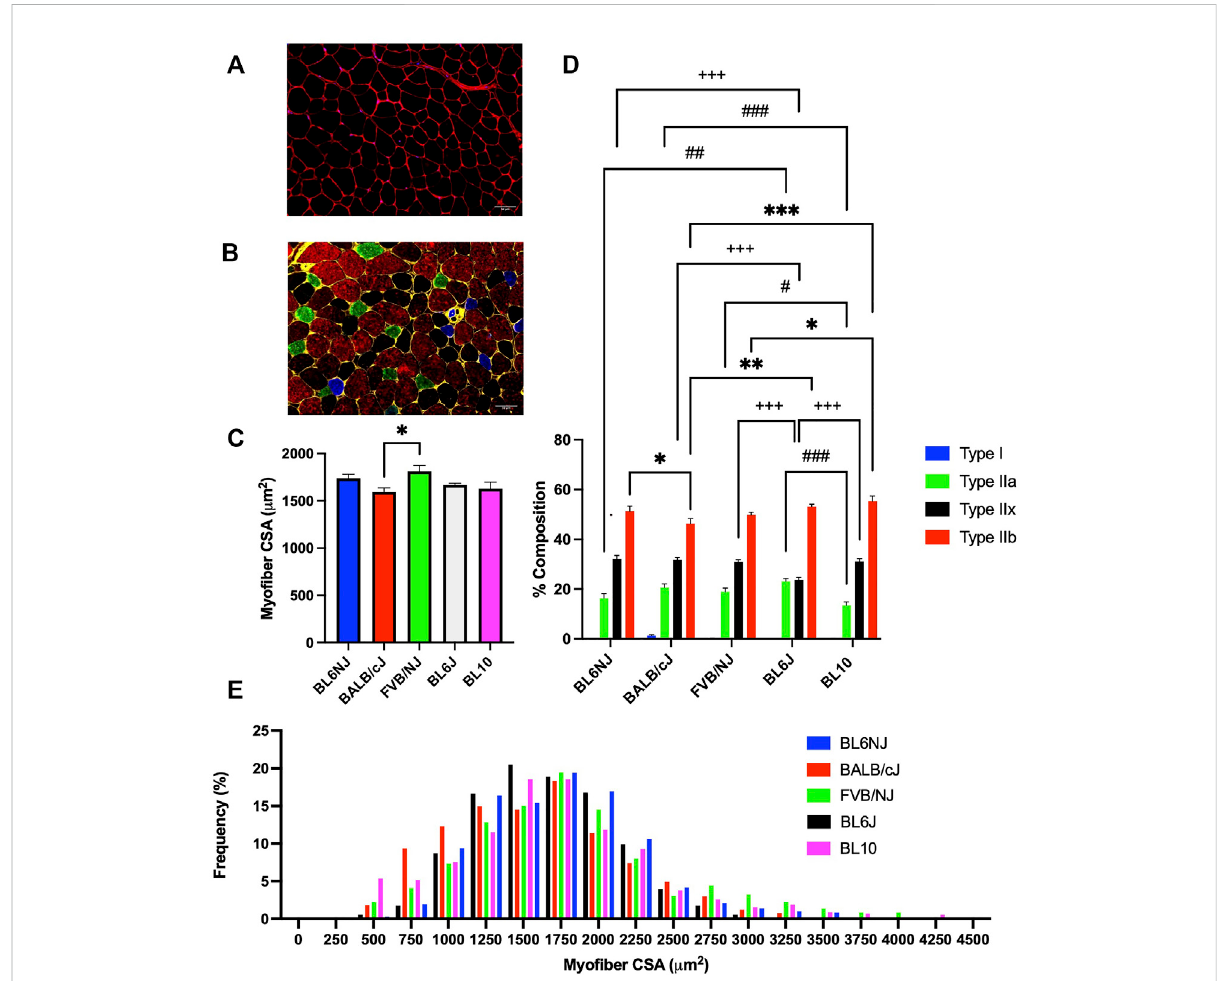
FIGURE 9 Averagemyo fi berCSAand fi bertypecompositionoftheEDLmusclefromvariousstrainsofmice. (A) Representativecross-sectionalimageofa BL10 EDL stained for dystrophin to outline the sarcolemma (red) and nuclei (DAPI, blue); (B) Representative cross-sectional image of a BL6NJ EDL probedfordystrophin(yellow)andthefollowingMHCisoforms — TypeI(blue),TypeIIa(green),TypeIIx(black),andTypeIIb(red); (C) AverageCSAof individual fi bers; (D) Average fi ber type distribution of individual muscles; (E) Frequency distribution of all fi bers measured in the EDL muscles from each strain. # = difference in Type IIa; + = difference in Type IIx; * = difference in Type IIb. Statistically signi fi cant difference is indicated by one symbol = p < 0.05; two symbols = p < 0.005; three symbols = p <